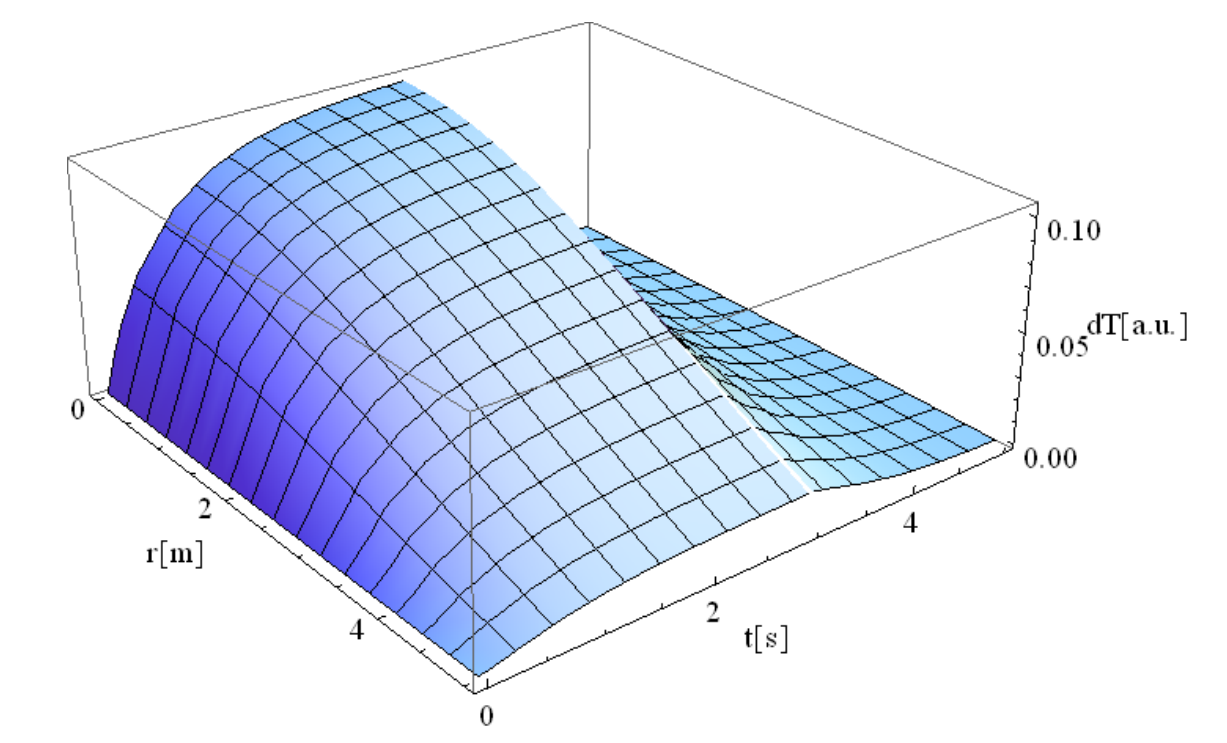
Figure 2. Results of the Fourier heat equation.